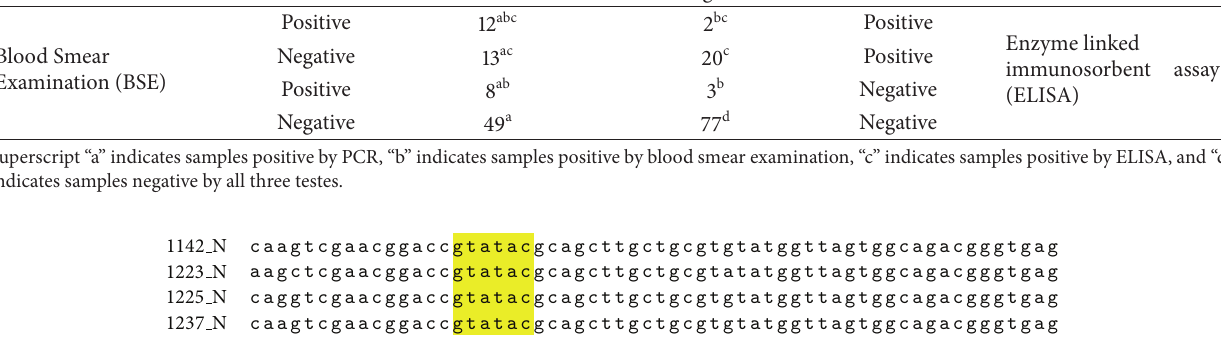
Figure 5: Multiple Sequence Alignment of the four samples positive by 16S rRNA nPCR showing A. marginale specific restriction site (highlighted are the restriction sites GTATAC).